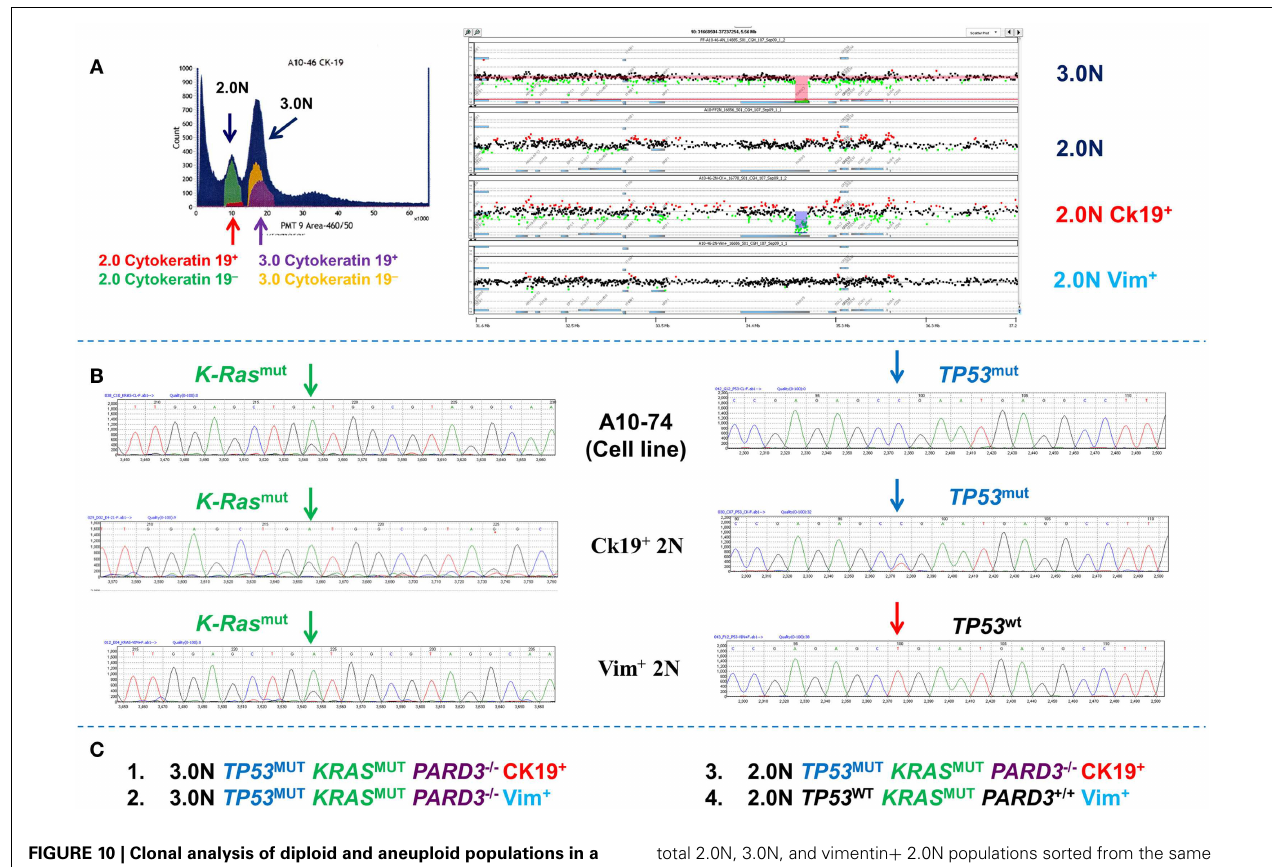
FIGURE 10 | Clonal analysis of diploid and aneuploid populations in a pancreatic ductal adenocarcinoma (PDA) biopsy. (A) DNA content cytokeratin 19 multiparameter sort of PDA biopsy. A small ( < 5%) CK19 + fraction was detected and sorted from the biopsy.These were compared to